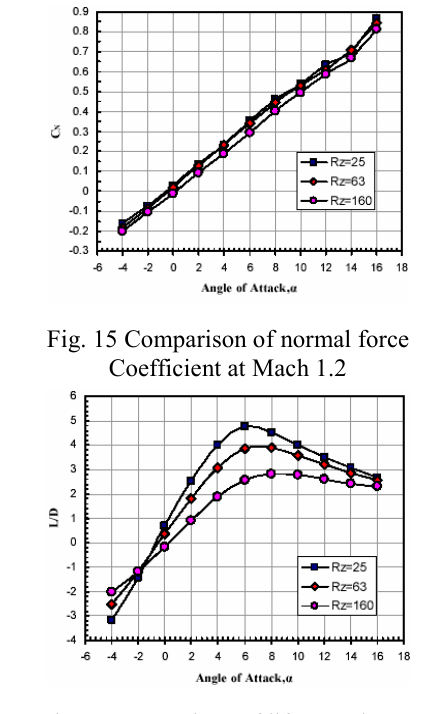
Fig. 12 Comparison of axial force Coefficient at Mach 0.3